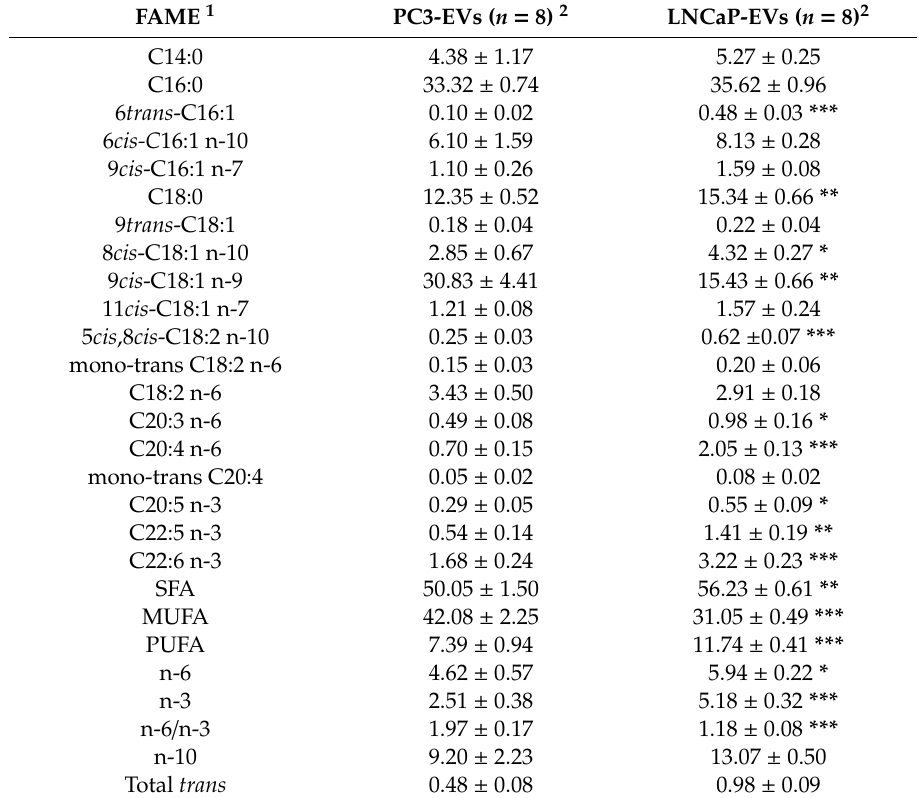
Table 2. Fatty acid methyl esters (FAME) (%rel. quant.) obtained from extracellular vesicles (EV) derived from two di ff erent prostate cancer cell